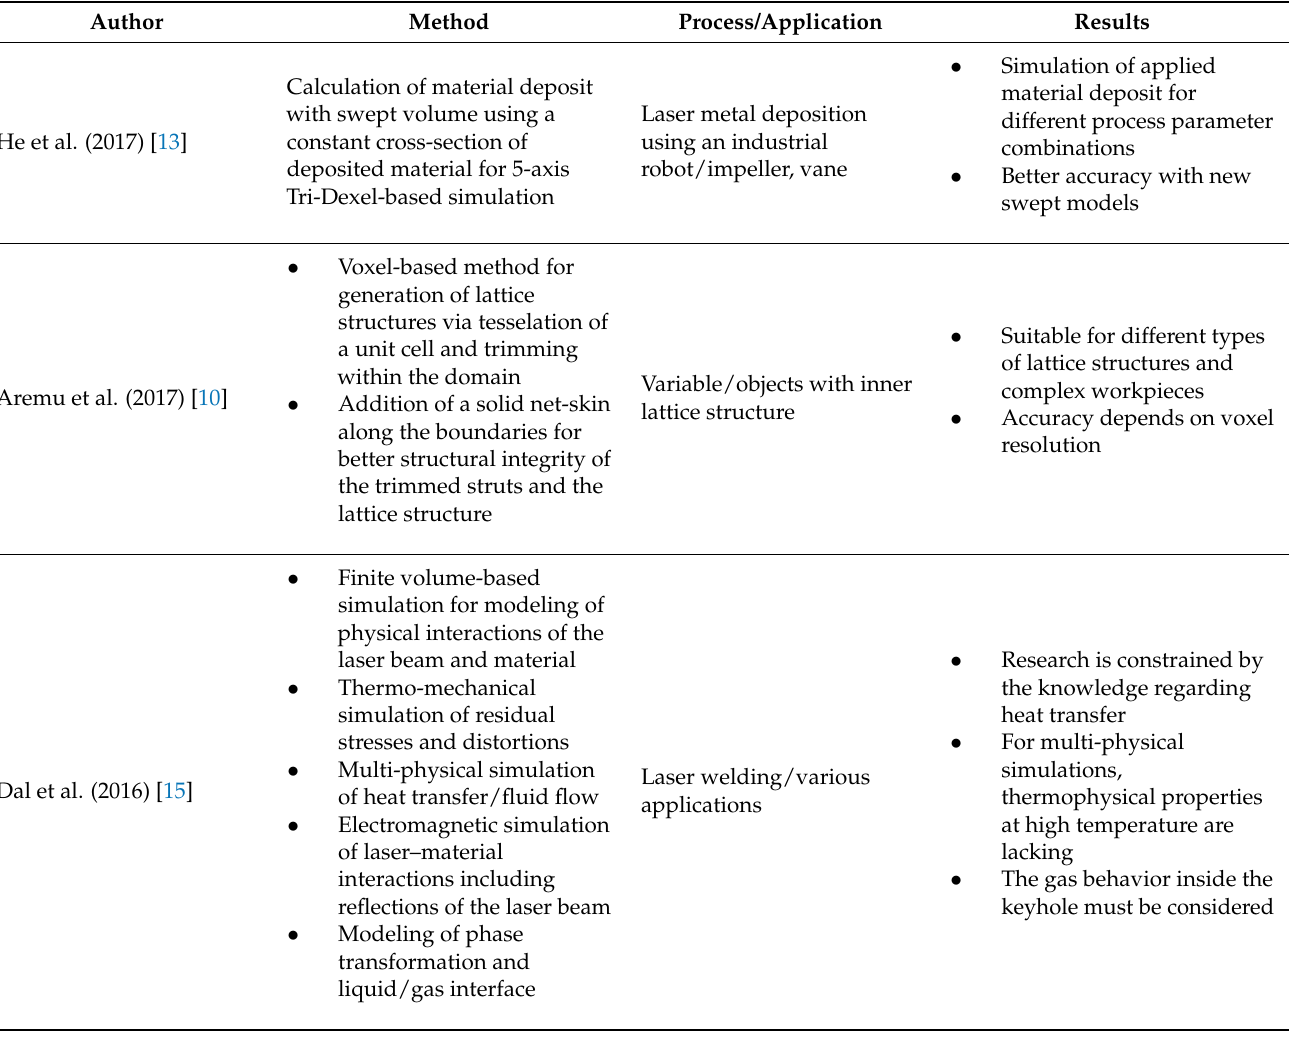
Table 1. Overview of the latest studies about the geometric simulation of additive